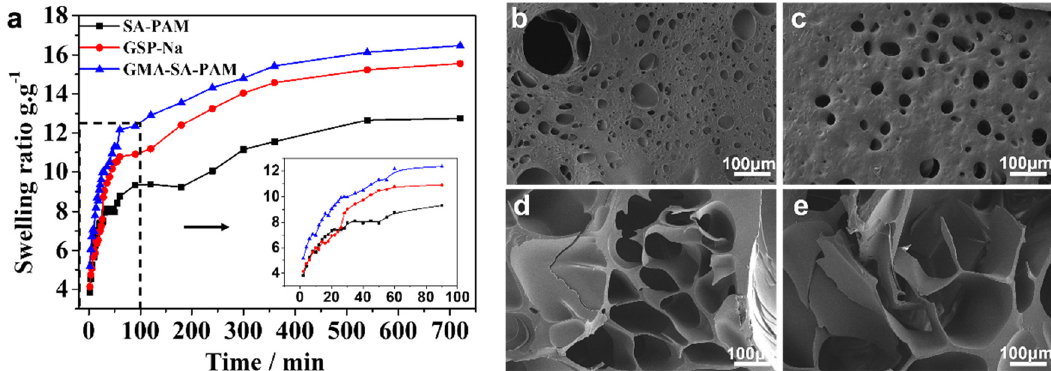
Figure 2: ( a ) Swelling ratios of SA - PAM, GAM - SA - PAM, and GSP - Na hydrogels with di ff erent swelling time in deionized water at 25°C. The surface SEM micrographs of ( b ) SA - PAM hydrogel and ( c ) GMA - SA - PAM hydrogel. The fracture SEM micrographs of ( d ) SA - PAM hydrogel and ( e ) GMA - SA - PAM